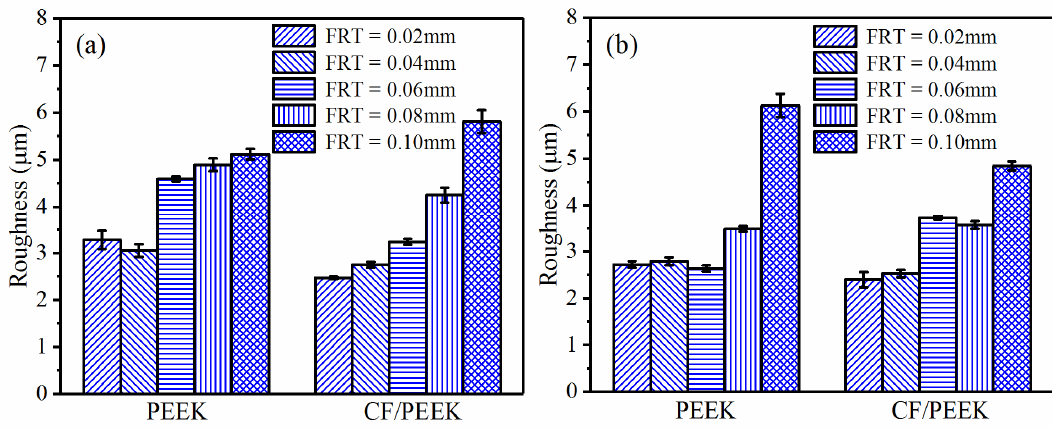
Figure 13. Roughness comparison of PEEK and CF/PEEK samples under different FRTs: ( a ) LT = 0.1 mm, RA = 0 ° , SS =